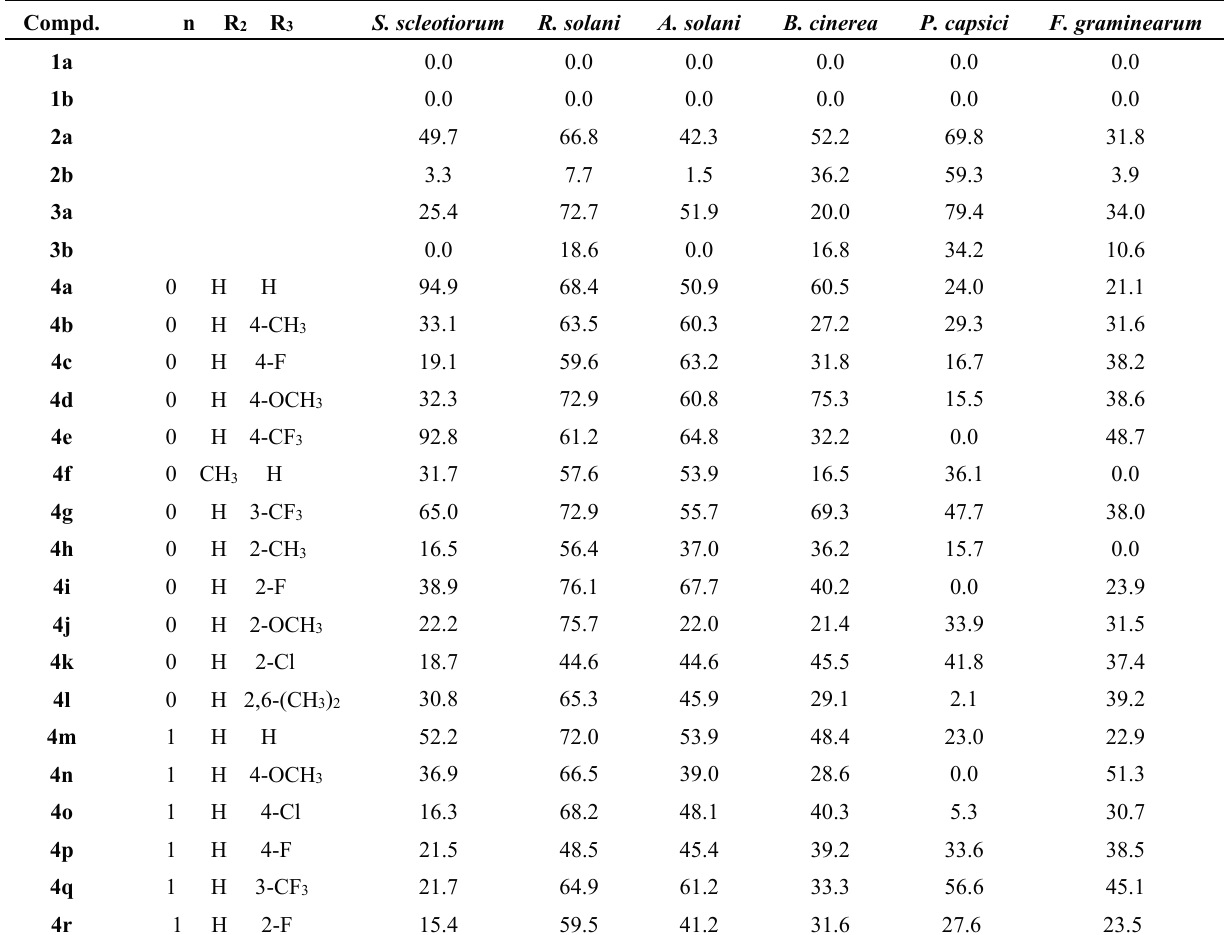
Table 1. The fungicidal activities (inhibition rate, %) of compounds 4 and 5 at 50 µg/mL.